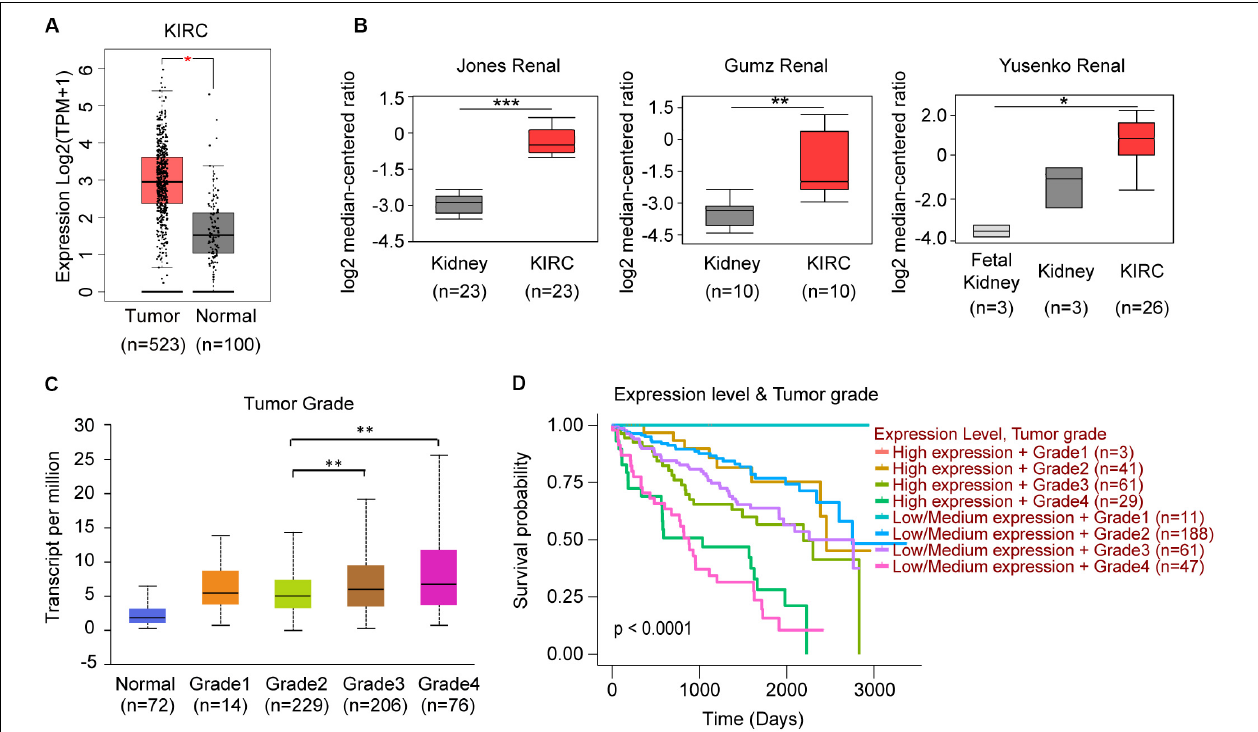
FIGURE 6 | TRAF3IP3 might play an oncogenic role in KIRC. (A) Comparison of KIRC normal and tumor tissues of TRAF3IP3 in TCGA database using GEPIA. (B) TRAF3IP3 expression in the studies of KIRC in Oncomine database. (C,D) Expression and Kaplan-Meier plot of TRAF3IP3 in KIRC based on tumor grade using UALCAN. * p < 0.05, ** p < 0.01, *** p < 0.001.